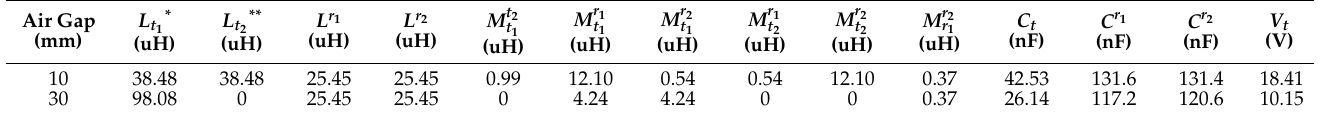
Table 2. Optimization results of the inductances, capacitances, and input voltages for two cases. * Air Gap L t 1 (mm)